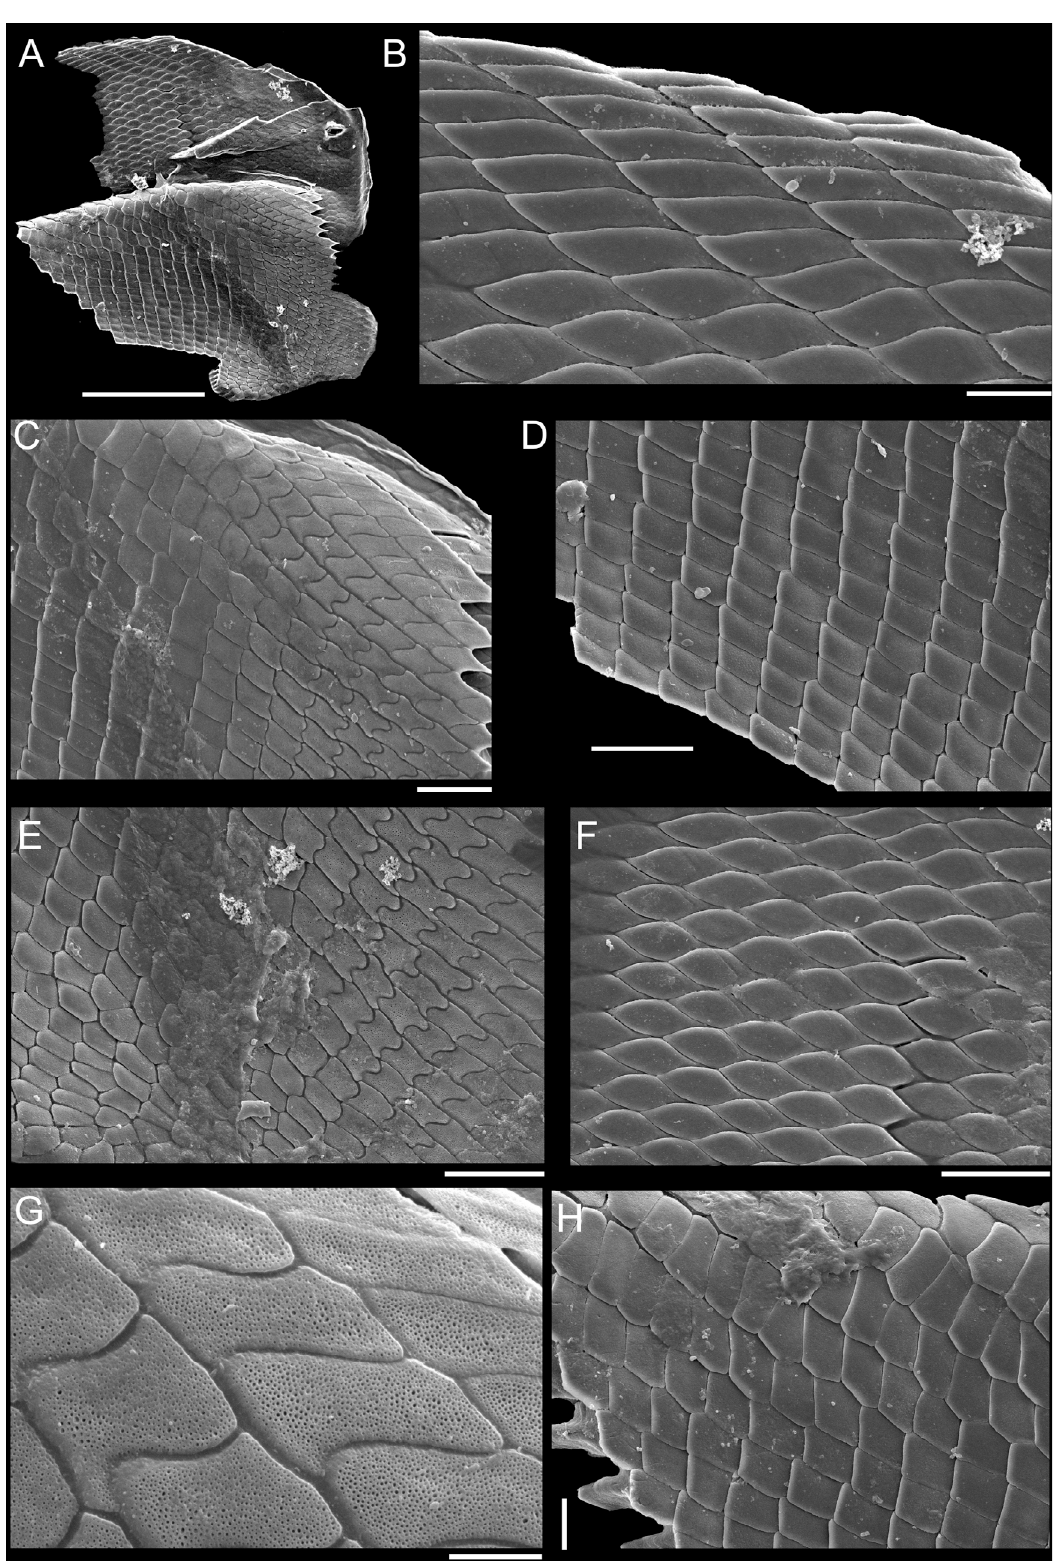
Fig. 32. “ Inella ” harryleei Rolán & Fernández-Garcés, 2008. A–H . FLMNH 450495. A–H . Jaw, inner (B, F) and outer (C–E, G–H) sides. Scale bars: A = 100 µm; B, H = 10 µm; C–F = 20 µm; G = 5